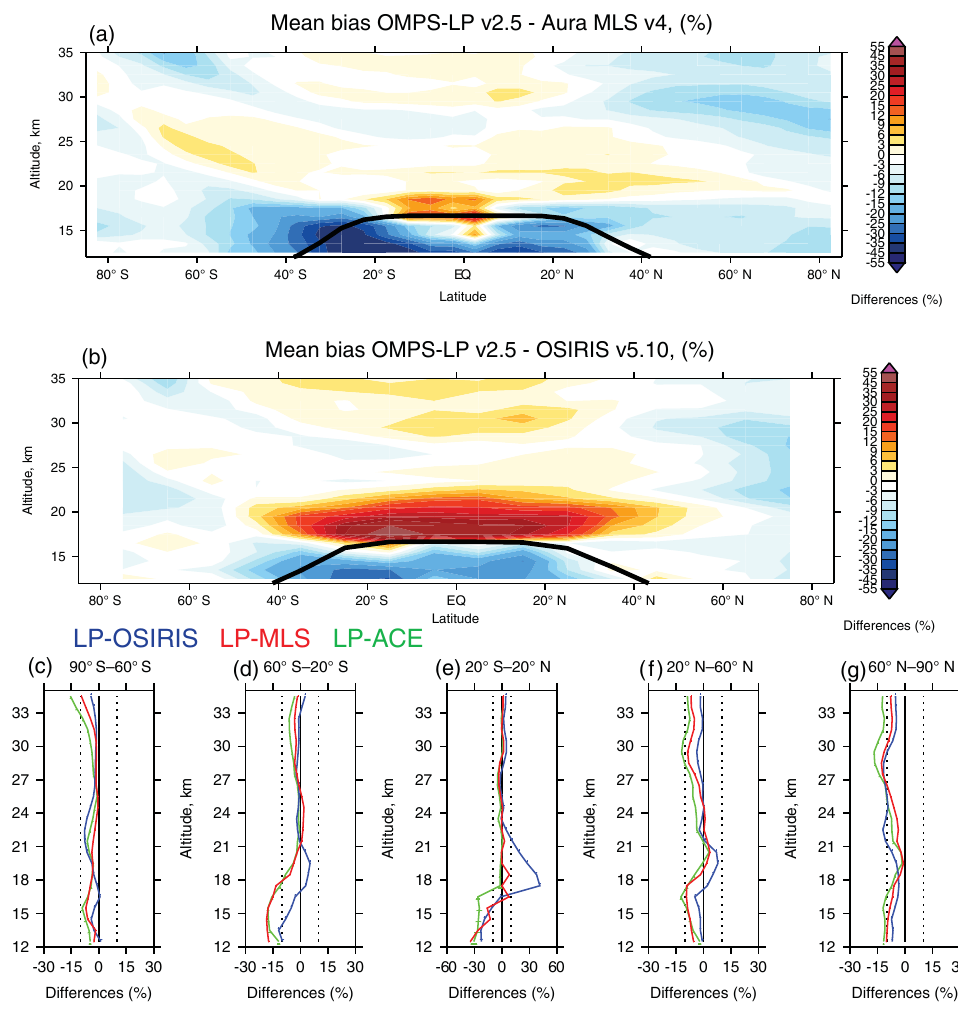
Figure 9. Same as Fig. 8 but for the VIS OMPS LP